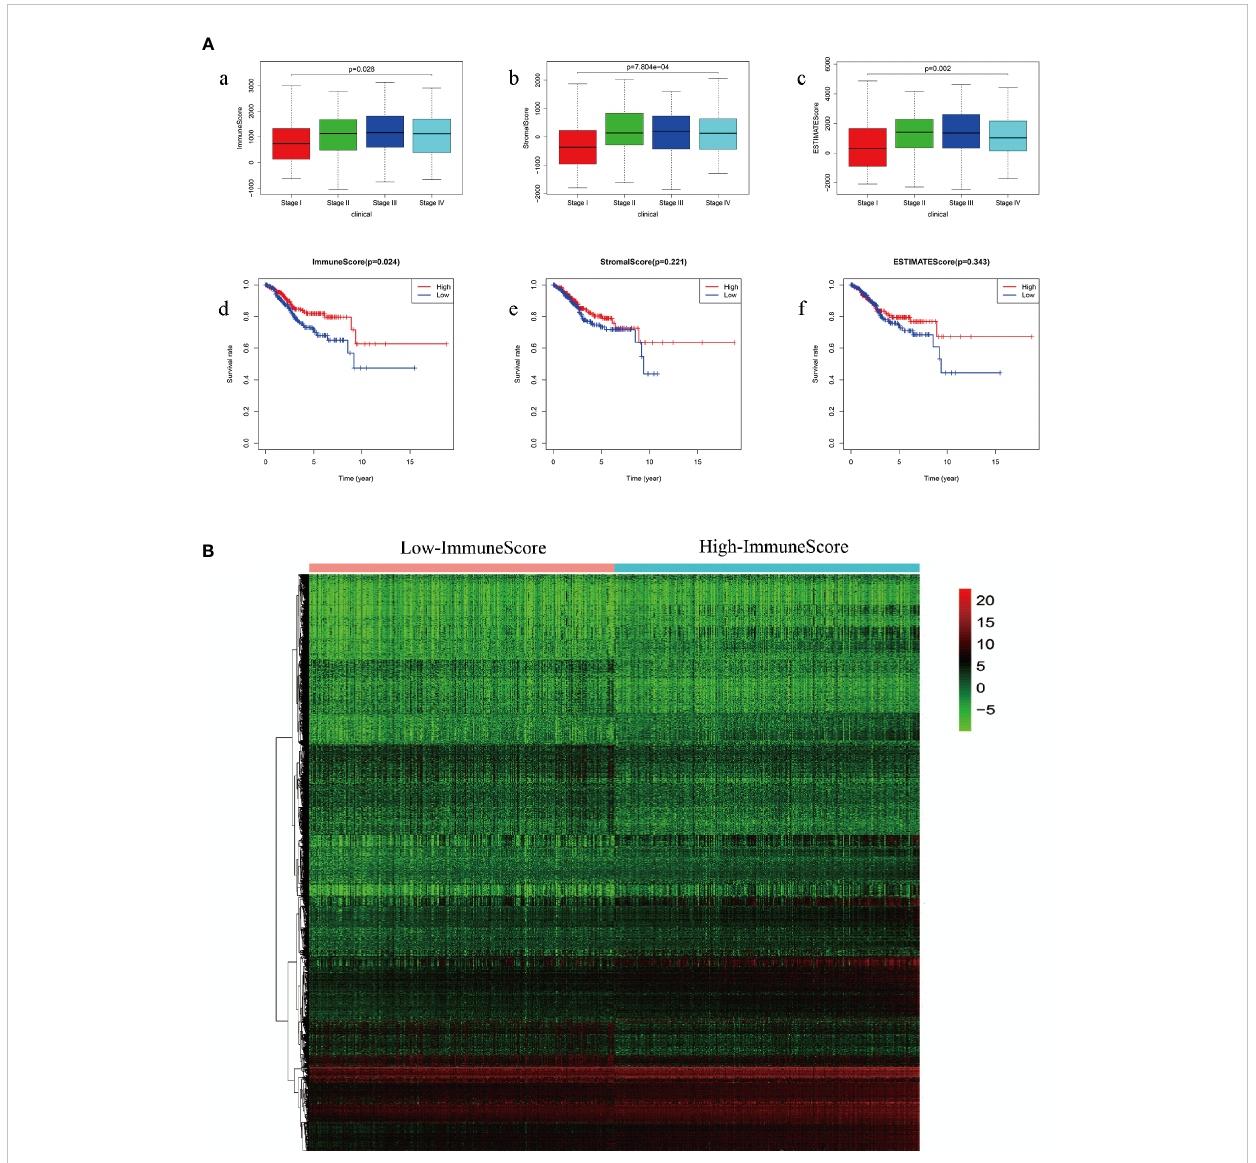
FIGURE 2 (A) Comparison of survival rates of ImmuneScore, StromalScore and ESTIMATEScore in different stages of endometrial carcinoma (a: ImmuneScore in different stages of endometrial carcinoma; b: StromalScore in different stages of endometrial carcinoma; c: ESTIMATEScore in different stages of endometrial carcinoma; d: comparison of survival rates of ImmuneScore; e: comparison of survival rates of StromalScore; f: comparison of survival rates of ESTIMATEScore) (B) ImmuneScore screens high-group and low-group differential